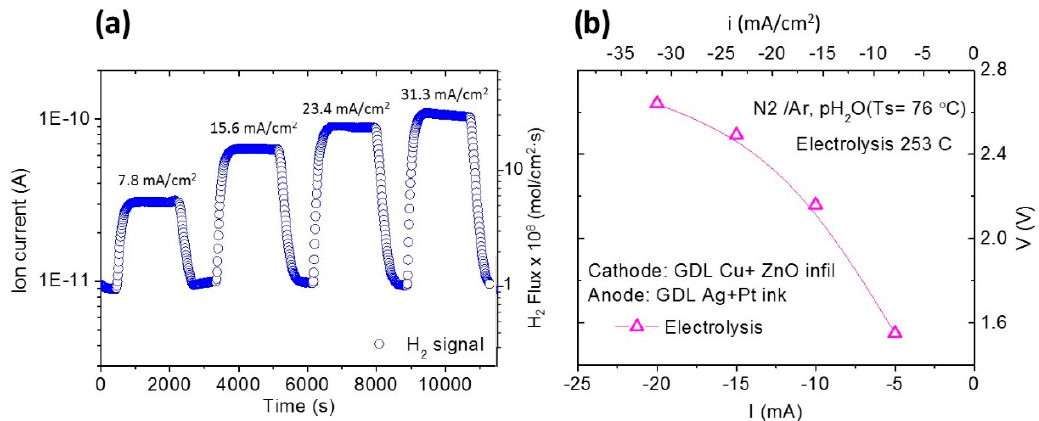
Figure 9. H 2 signal of the cathode outlet as a function of the applied current ( a ) and i - V curve of the electrolysis cell ( b ) at 253 °C and atmospheric pressure.